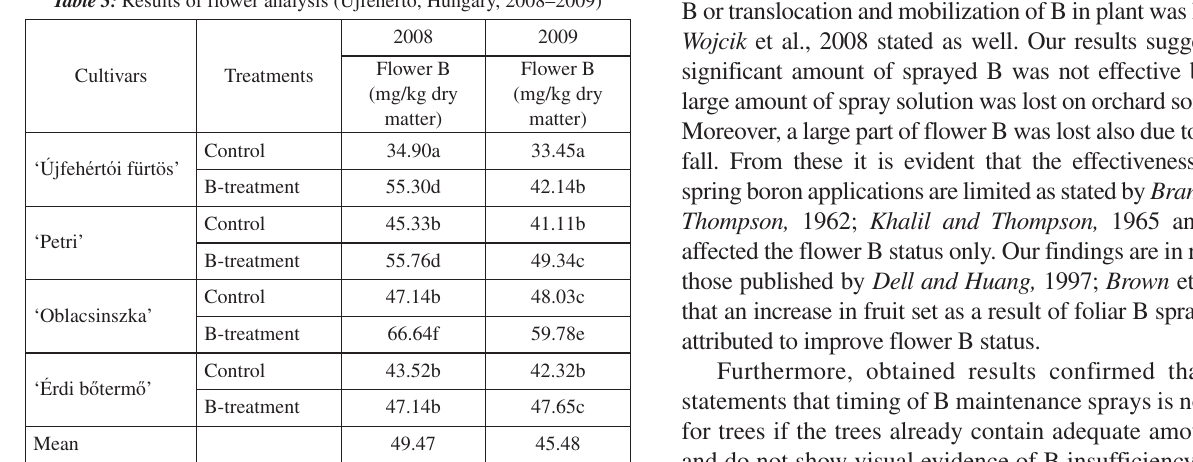
Table 3: Results of flower analysis (Újfehértó, Hungary, 2008–2009)